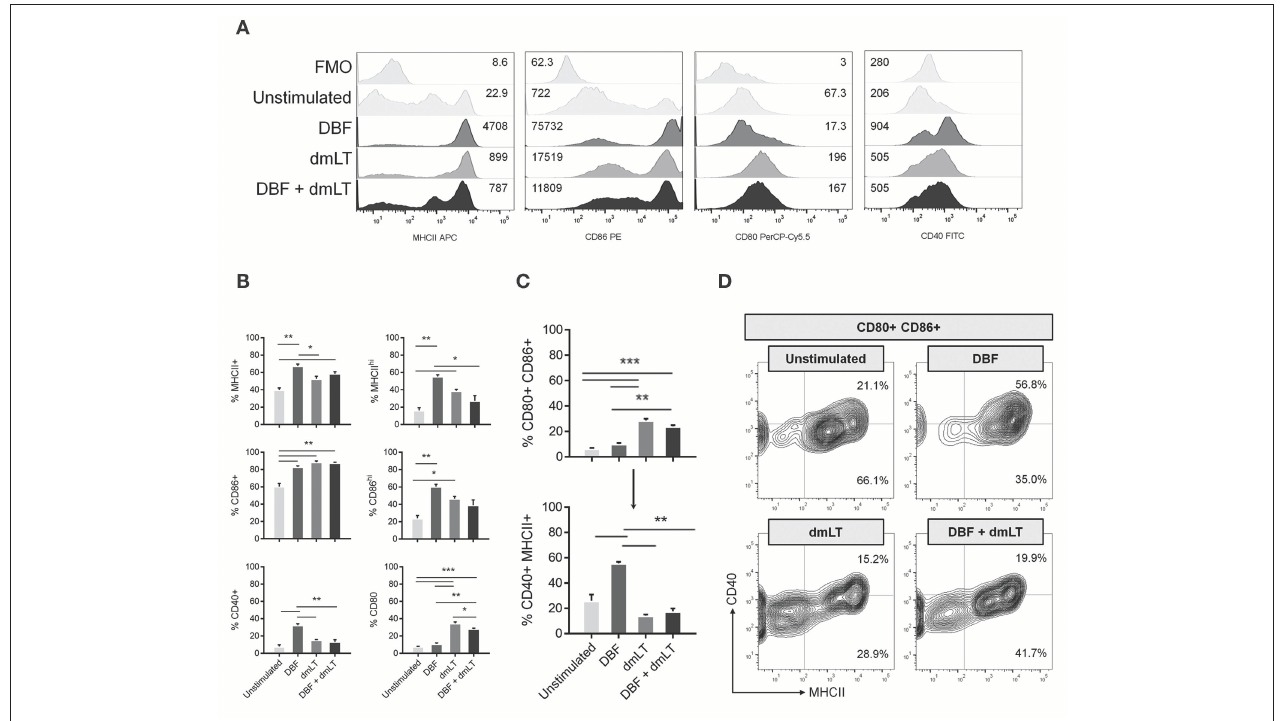
FIGURE 2 | Antigen exposure promotes activation of bone-marrow derived DCs. Mouse bone marrow cells were differentiated into CD11c + cells by 8-day culture in the presence of GM-CSF as described in Materials and Methods. (A) DC populations exposed to PBS, DBF, dmLT, and the combination DBF + dmLT were analyzed for expression of activation markers MHCII, CD86, CD80, and CD40 by flow cytometry. Stacked histograms show the fluorescence distribution and MFI values for each marker in a representative sample of each treatment. Some treatments induce a bi- or trimodal distribution of marker fluorescence. Fluorescence minus one (FMO) controls are shown for comparison. (B) Differences in positive populations for each marker were assessed by setting a cut-off of negative fluorescence with FMO samples. Percent positive populations for MHCII, CD86, CD40, and CD80 are shown using that criterion. Additionally, trimodal distributions for MCHII and CD86 allowed for an alternative histogram gate for distinct populations MHCII hi and CD86 hi . Their differences across treatments are also shown. (C) Percentages of the total DC population were analyzed for co-expression of CD80 and CD86 (top graph). The gated population double positive for CD80 and CD86 was further analyzed for co-expression of CD40 and MHCII (bottom graph). (D) Contour plots for CD80 + CD86 + populations further represent the differences in their distribution of MCHII + , CD40 + , and MHCII + CD40 + cells. Each bar represents the mean and SEM of duplicate biological samples. Statistical significance was analyzed with an ordinary one-way ANOVA with a Tukey post-hoc test. All comparisons tested with an α value of 0.05. * p < 0.05, ** p < 0.01, *** p <